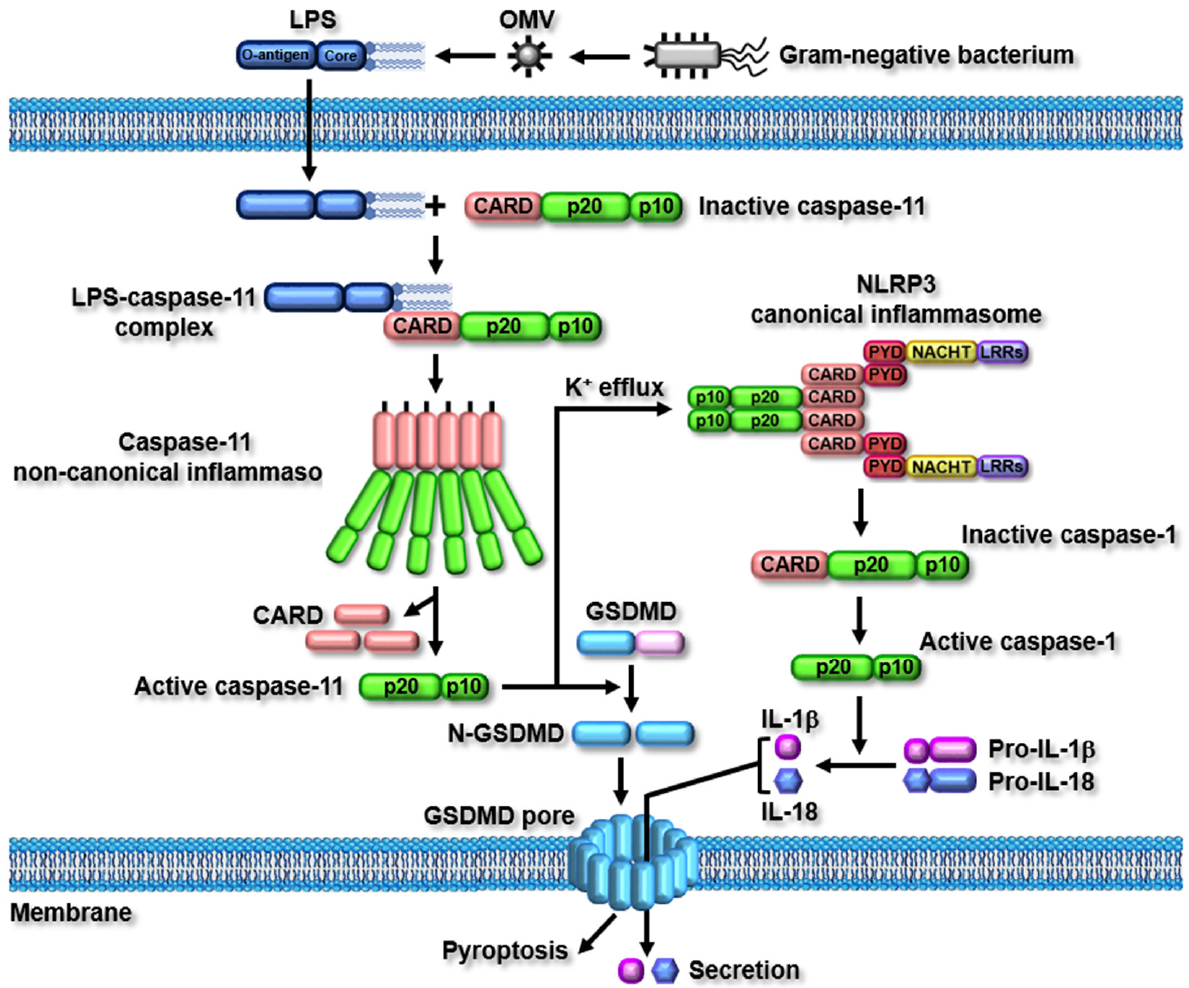
Figure 2. Caspase-11 non-canonical inflammasome-activated signaling pathways. Activation of caspase-11 non-canonical inflammasome induces the proteolytic processing of GSDMD. The pro- cessed N-GSDMD fragments move to the cell membrane and then generate GSDMD pores, leading to pyroptosis. Activation of caspase-11 non-canonical inflammasome also induces NLRP3 canonical inflammasome-mediated proteolytic activation of caspase-1, and the active caspase-1 induces the proteolytic maturation and secretion of IL-1 β and IL-18 through GSDMD pores.